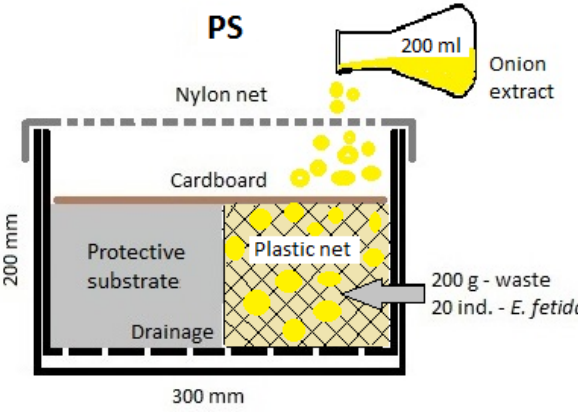
ff ectiveness in PS